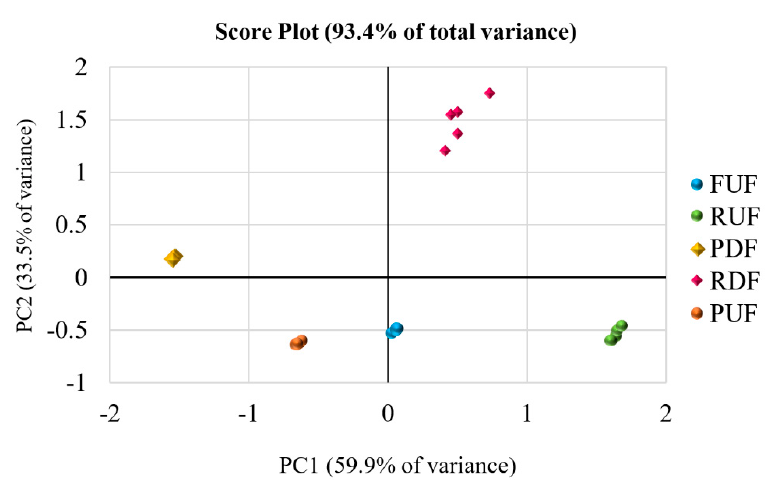
Figure 8. Principal component analysis score plot of the studied UF/DF samples using NMR and UV—Vis data.